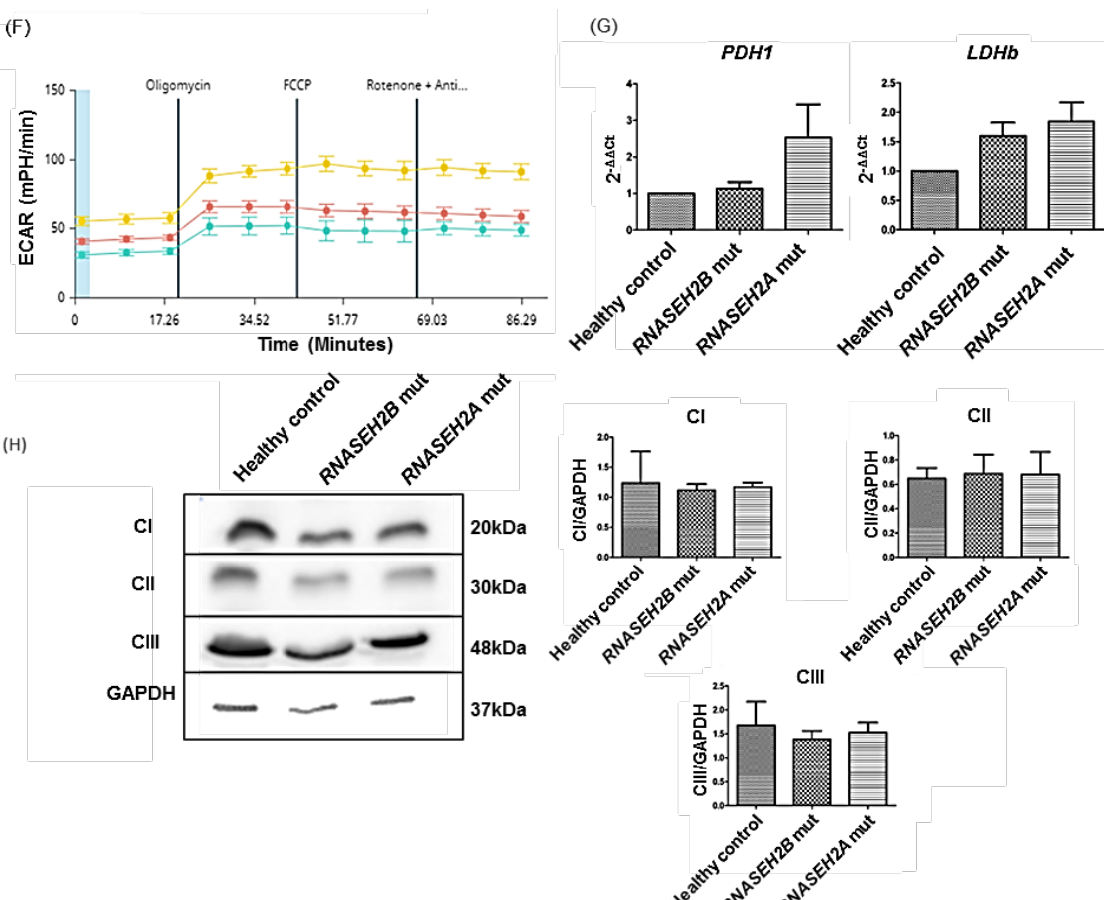
Figure 3. Metabolic and energetic status of LCLs derived from RNASEH2B - and RNASEH2A -mutated AGS patients. ( A ) Oxygen Consumption Rate (OCR in pmol/min) was measured using a Seahorse XFe24 Analyzer. OCR was measured in three independent experiments before (basal respiration) and after the addition of Oligomycin, FCCP and Rotenone/Antimycin A, allowing the determination of each component of the respiration chain. ( B ) OCR (pmol/min) of a representative experiment with standard errors reflecting the between-well variance within the experiment. Healthy control was indicated by the blue line, RNASEH2B -mutated LCLs by the red line and RNASEH2A -mutated LCLs by the yellow line. Three biological independent experiments have been performed. Data were collected and averaged from five separate wells for each cell line. ( C ) ATP synthesis, ( D ) Proton leak, ( E ) Spare respiratory capacity. ANOVA test and post hoc analysis Tukey’s Test have been performed. * p < 0.05, ** p < 0.01, *** p < 0.001. ( F ) Energetic status of LCLs derived from mutated AGS patients